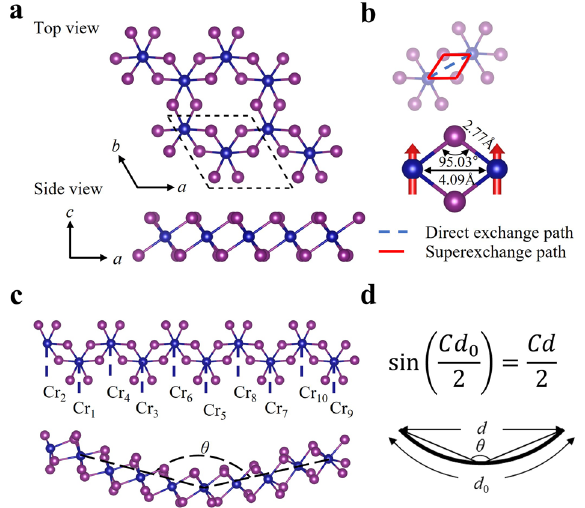
Fig. 1 Structure and bending deformation of a CrI 3 nanoribbon. a Top and side views of a CrI 3 monolayer. The unit cell is indicated by the black dashed quadrilateral. b Schematic pathways for spin coupling between neighboring Cr atoms. c Construction of CrI 3 zigzag nanoribbons in fl at and bent forms. d Geometric bending diagram, where d 0 and d are the straight distances between Cr 1 and Cr 9 before and after bending. C corresponds to the curvature of the nanoribbon induced by bending. The Cr and I atoms are represented in blue and violet, respectively. bottom I sub-lattices are equal to 95.03°. Due to the octahedral coordination, the 3 d orbitals of the Cr atom are split into the lower